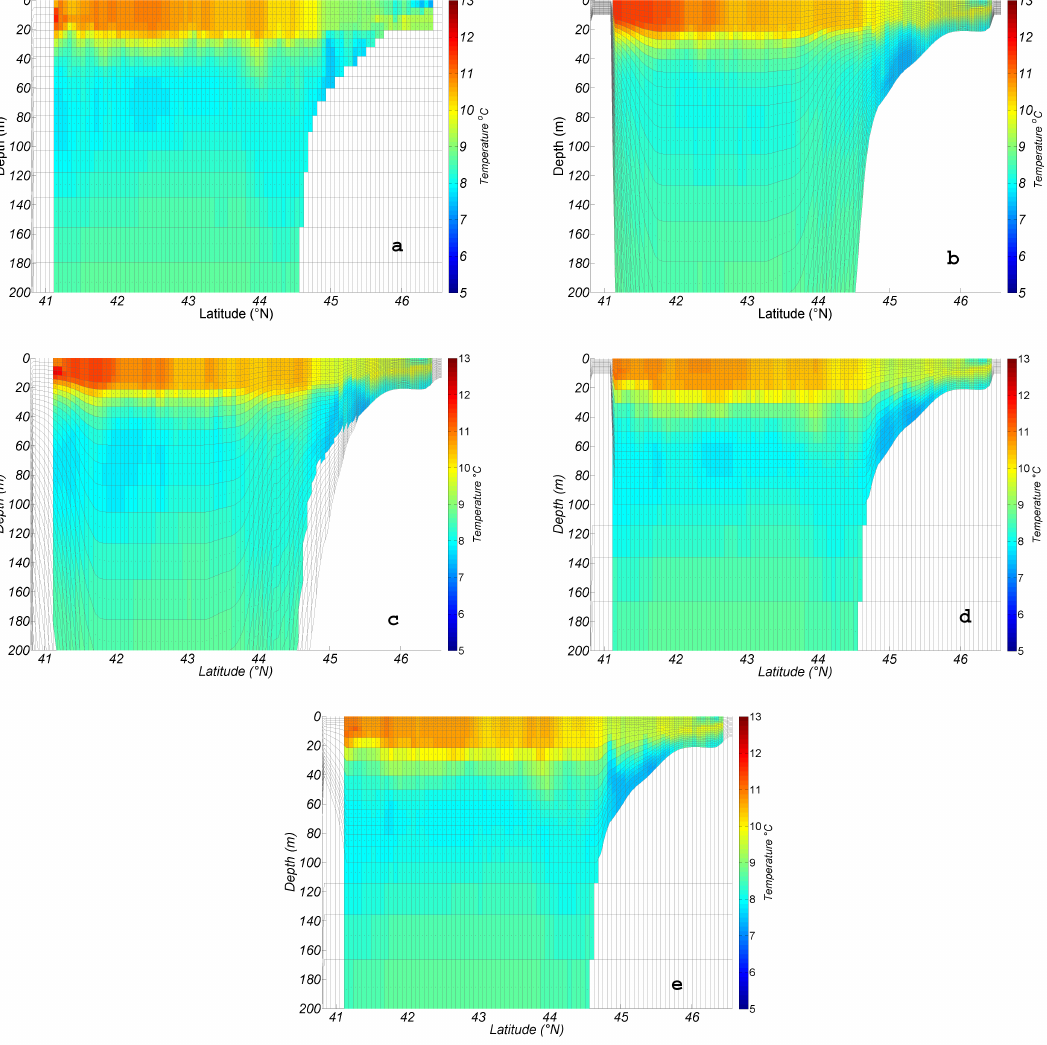
Fig. 7. Temperature transects along 31 ◦ E for 16 April 2007: (a) ZCO; (b) SCO; (c) Z*SIG; (d) SZH; (e)